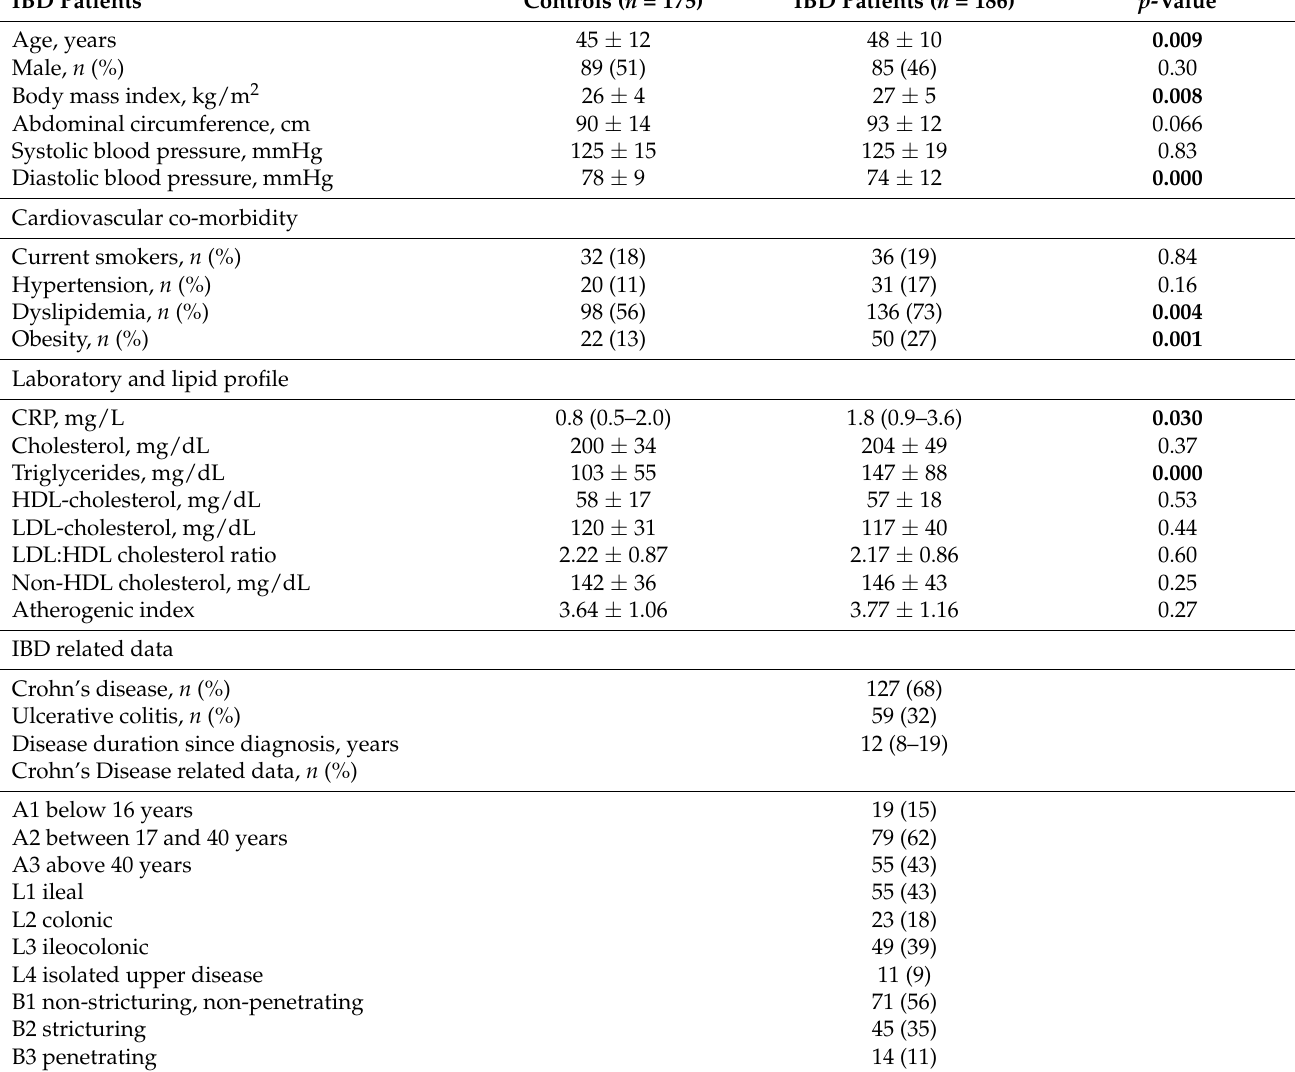
Table 1. Characteristics of patients with inflammatory bowel disease (IBD) and